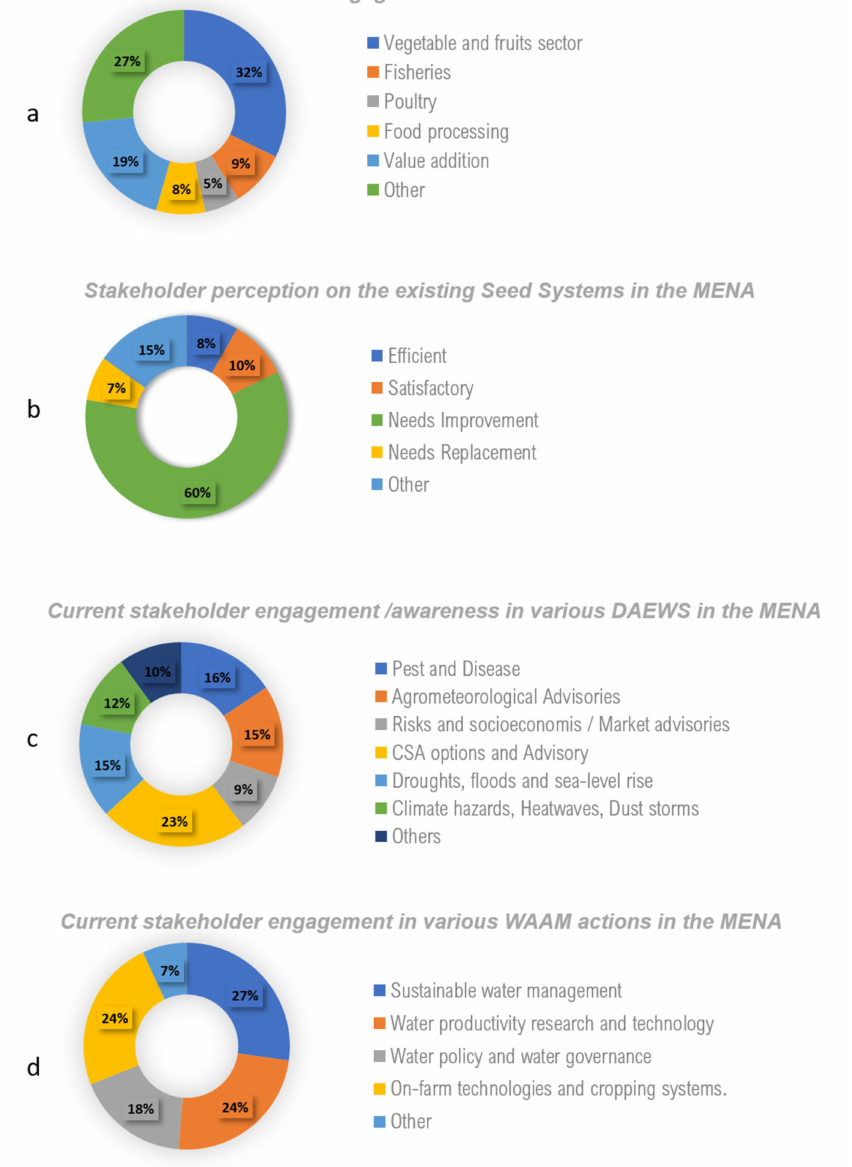
Figure 6. The pie chart represents: ( a ) the current level of stake holders’ engagement in different value chains in MENA, ( b ) perception on existing seed systems, ( c ) current awareness to the digital advisory early warning systems (DAEWS), and ( d ) current engagement in WAAM